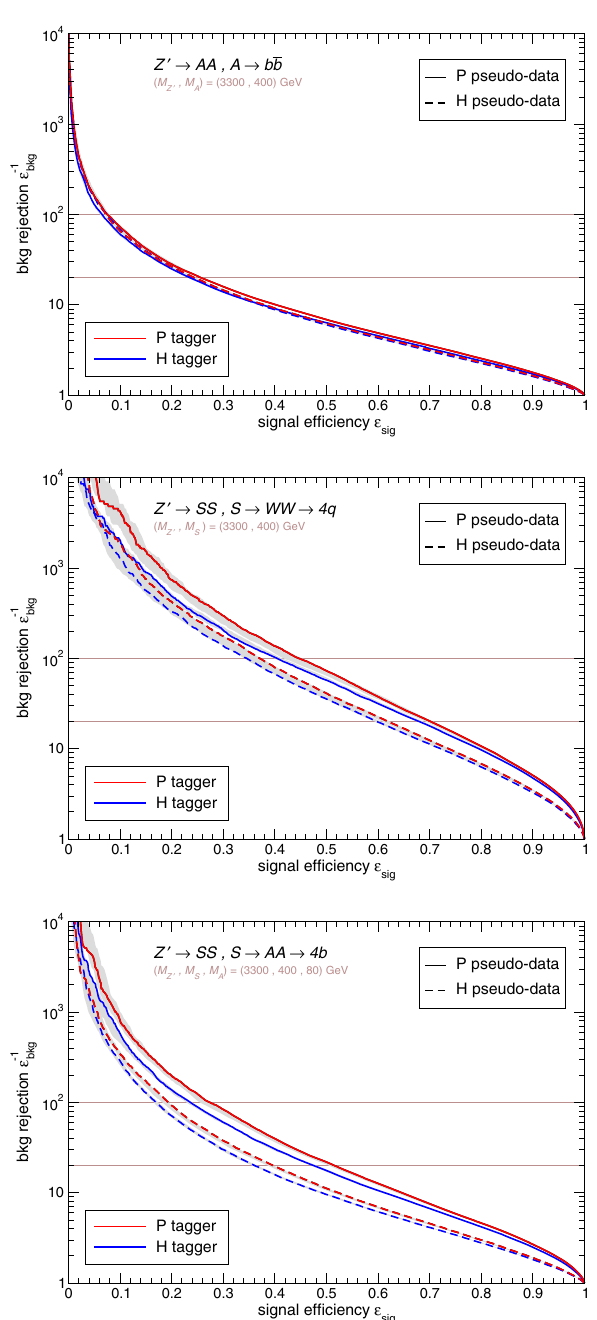
Fig. 7 ROC curves for jets with m J ∼ 400 GeV